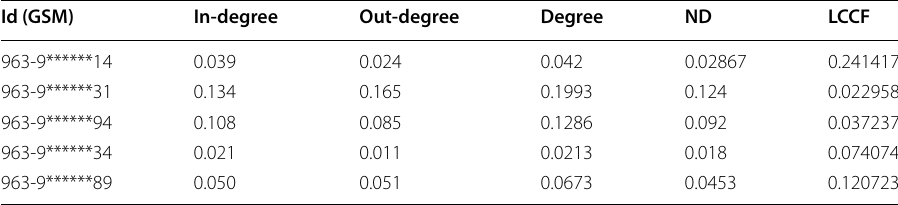
Table 5 Sample of SNA centrality measures Id